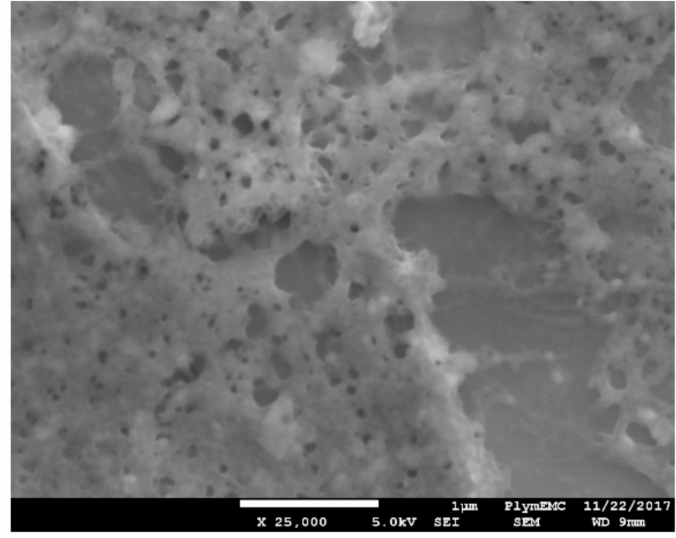
Figure 7. SEM image displaying bare graphene functionalised with Pyr-NHS linker, Ab, BSA and the corresponding hCG antigen. Scale bar is 1 µ